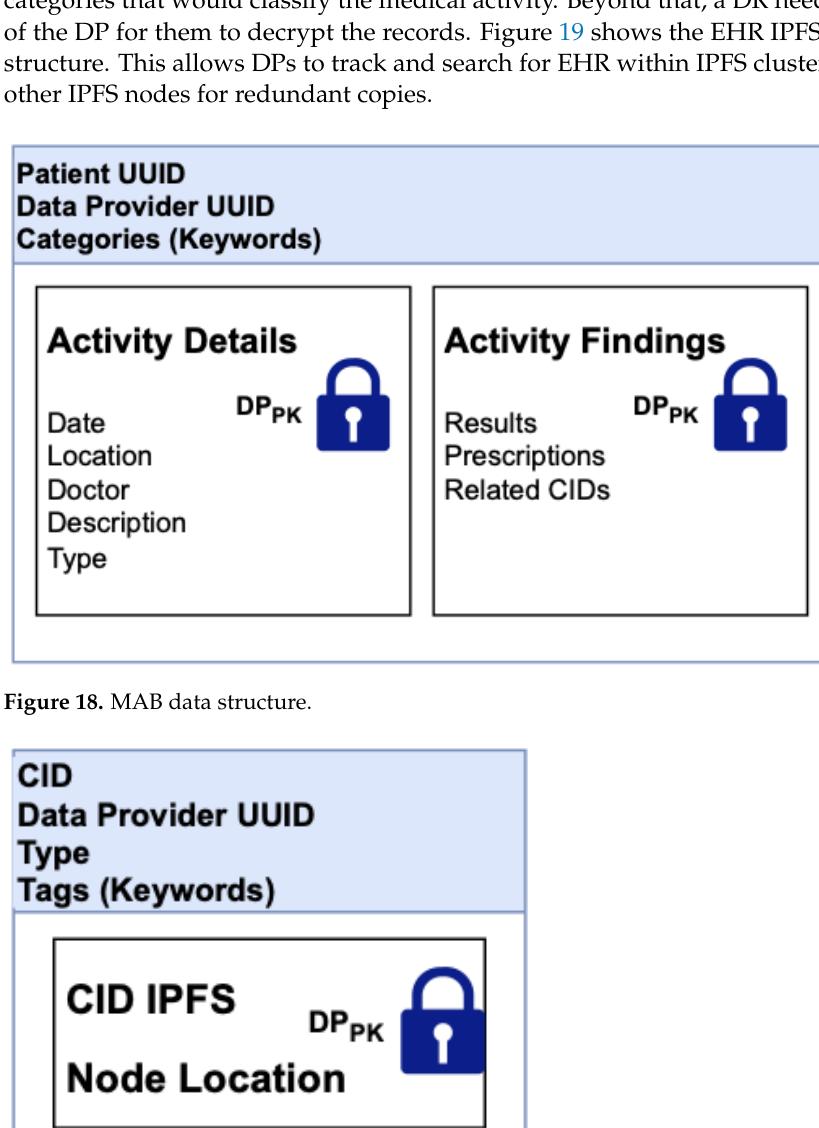
Figure 19. EHR IPFS directory .